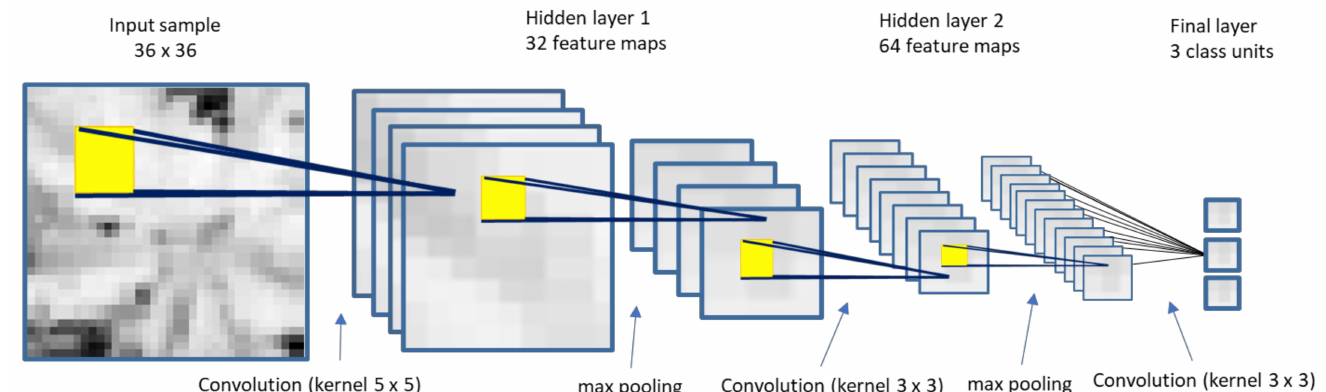
Figure 5. Example of the convolutional neural network (CNN) model architecture developed for the detection of banana crowns with samples input based on the 28 August image